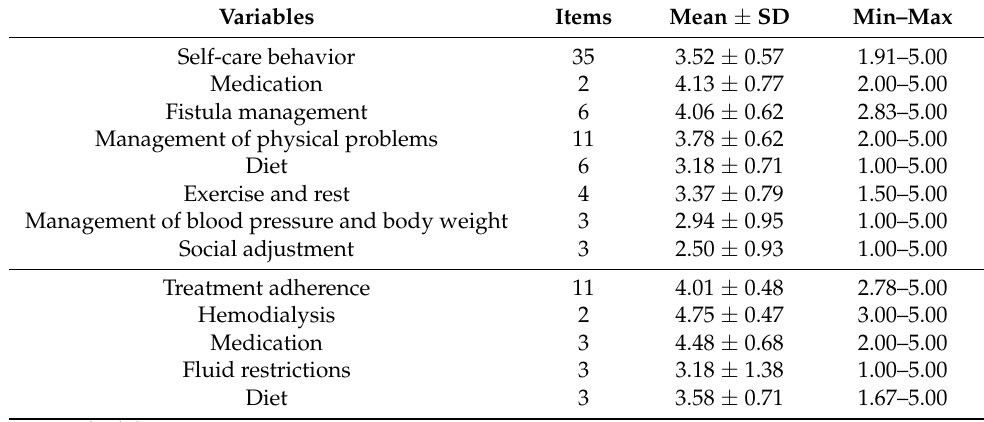
Table 2. Descriptive statistics of measured variables ( n = 100).